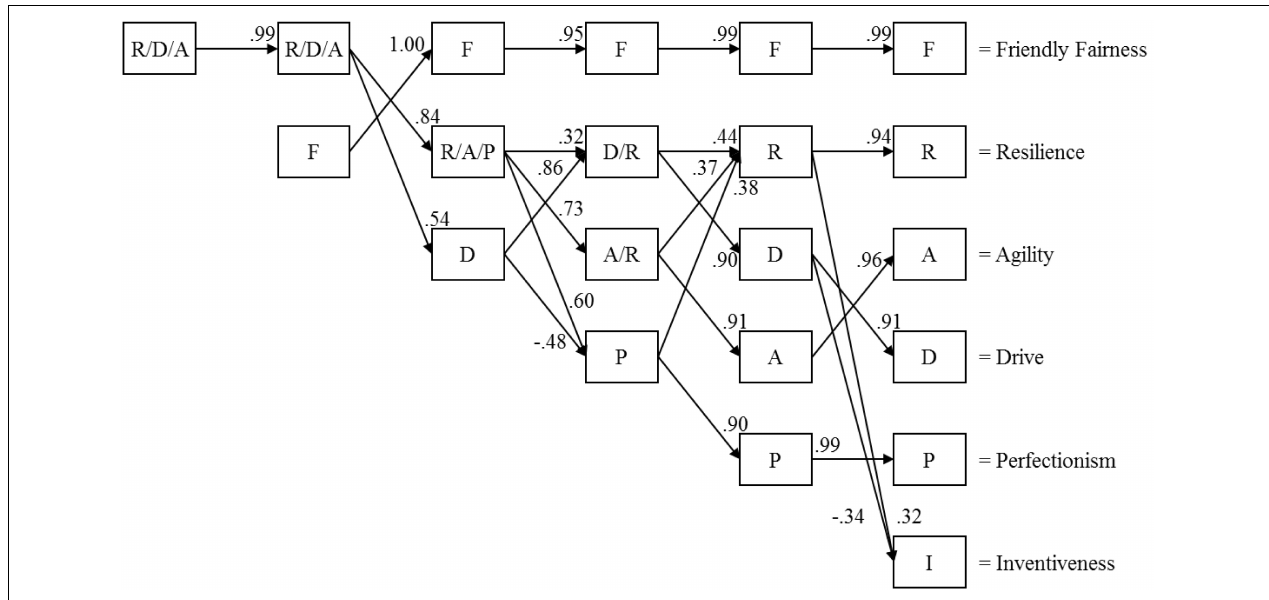
FIGURE 1 | Factor tree with Pearson’s correlations > 0.30 of the 1- to 6-PC solutions of the 321 ipsatized sport adjectives ( N = 555).